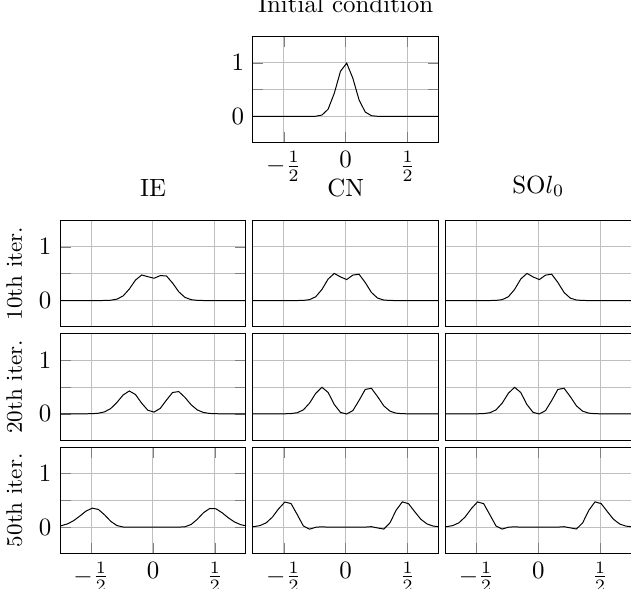
x 2 /0.01 as the initial condition. − (cid:0) (cid:1)